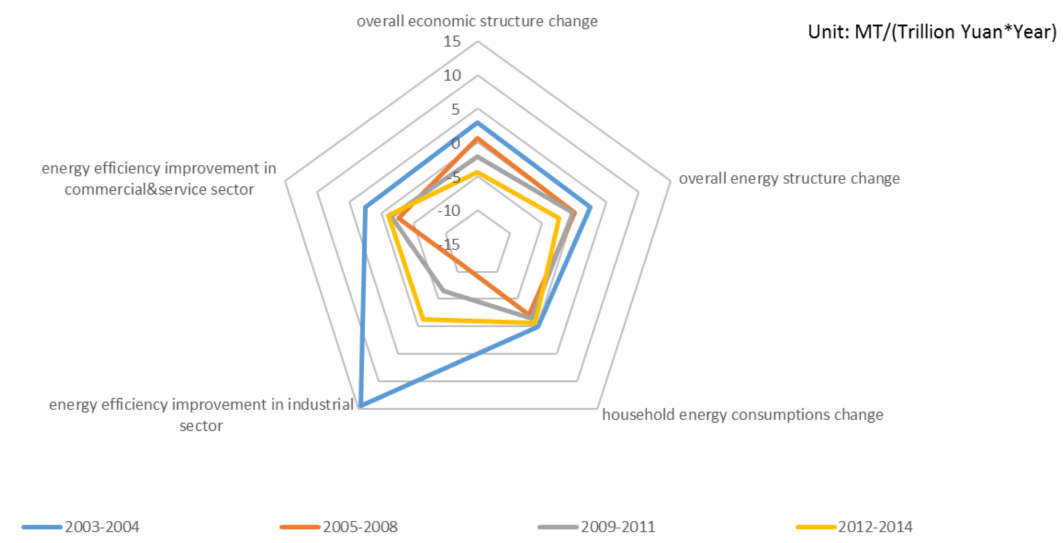
Figure 11. The Average Phase Contributions of Driving Factors to China’s Economic Carbon Intensity